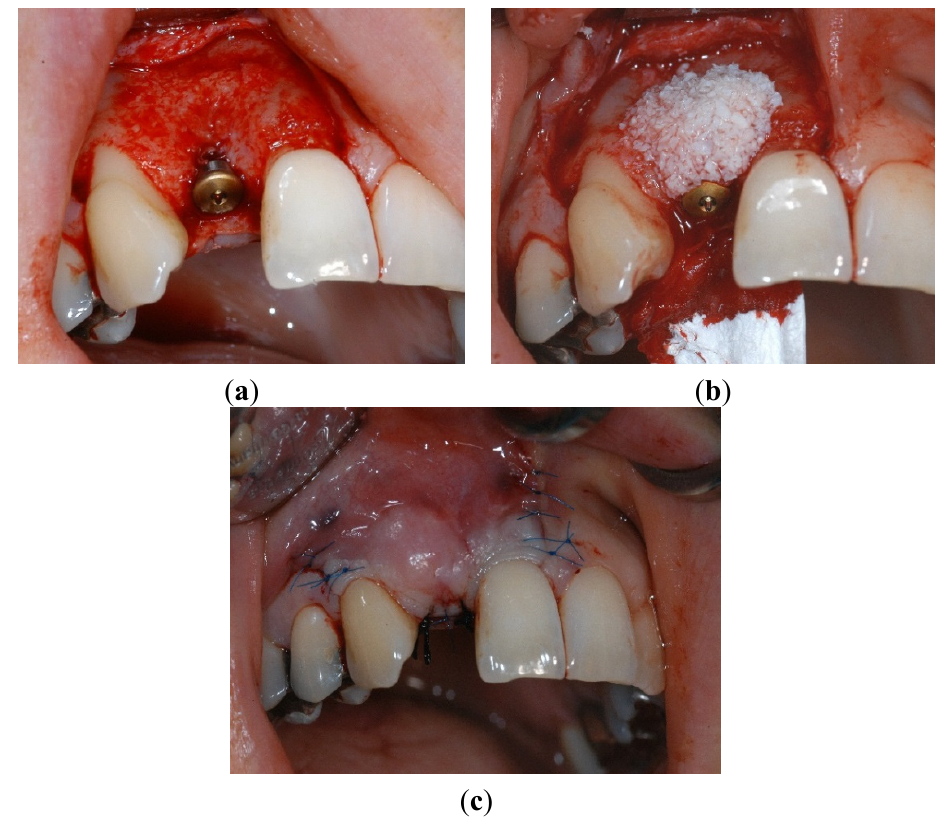
Figure 5. Vestibular bone defect after implant placement in position 12 ( a ); Augmentation